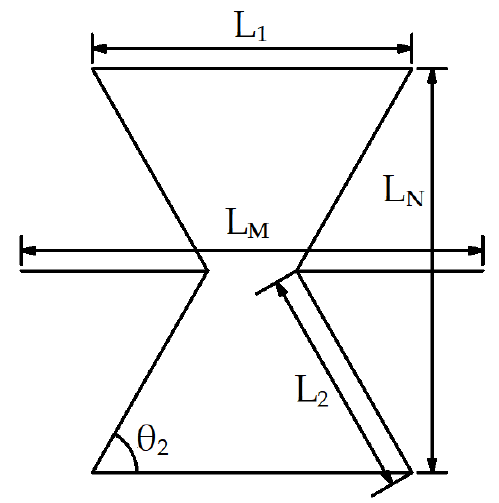
Figure A2. The geometrical configuration between point A 1 and point A 2 . Therefore, the distance between point A 1 and point O is m times the width of the re-entrant honeycomb cell. The distance between point A 2 and point O is n times the width of the re-entrant honeycomb cell, which can be expressed as: ,.....)3,2,1,......;3,2,1(tan 1 Figure A3 shows the geometrical configuration of a re-entrant honeycomb cell; L N and L M can be expressed as: